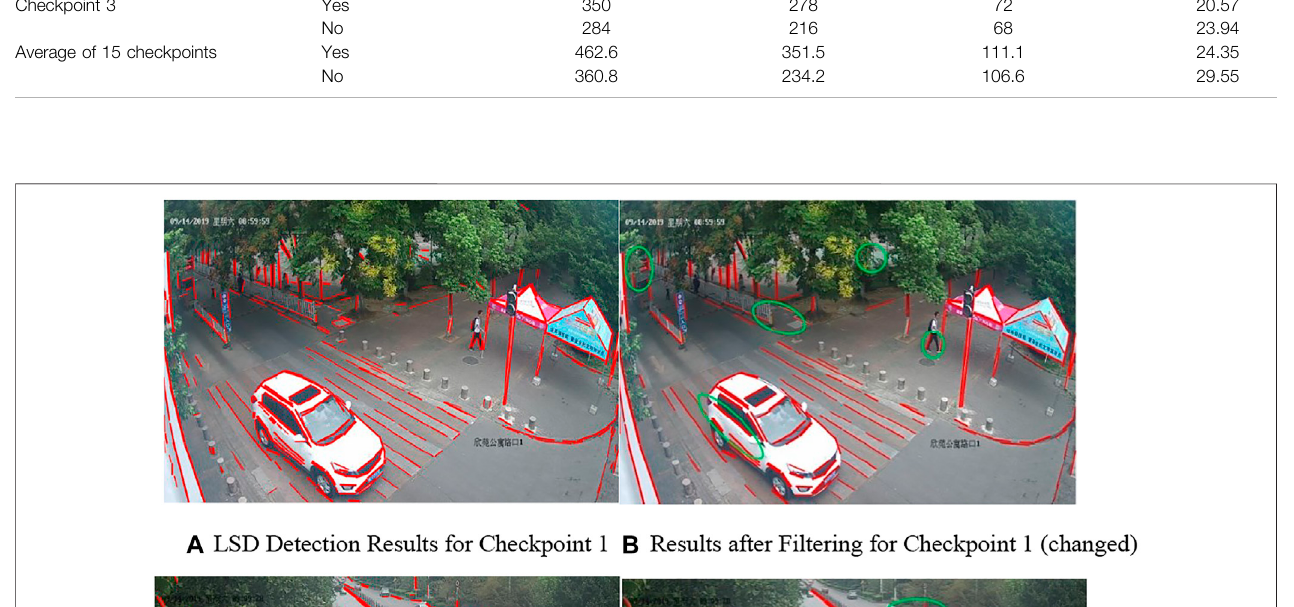
TABLE 2 | Comparison of line detection results. Image Are there Checkpoint 1